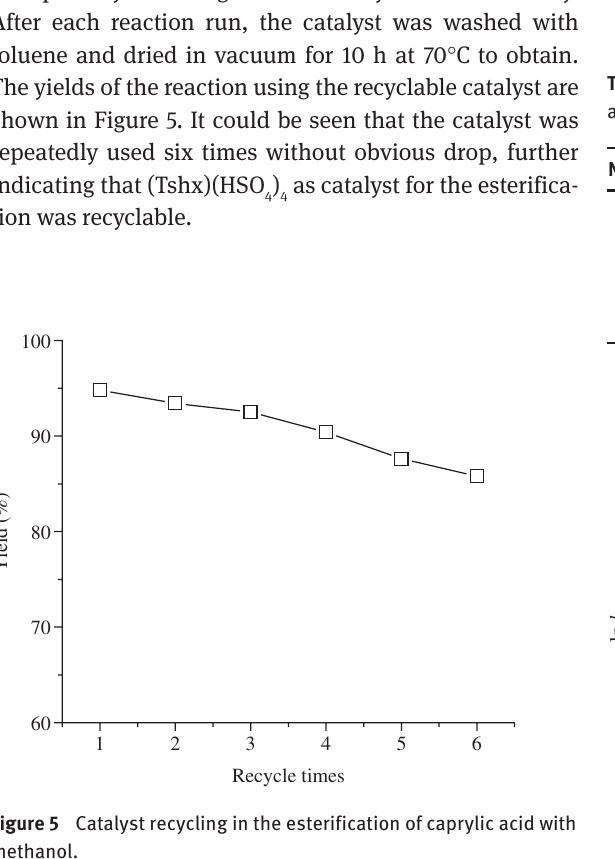
) under different temperatures. 4 4